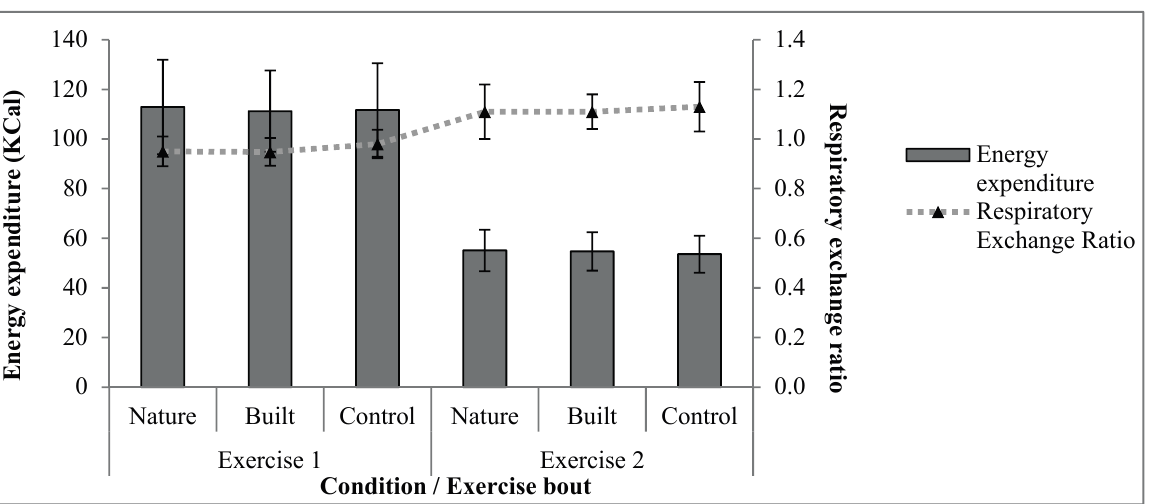
Figure 2. Mean (±SD) energy expenditure and respiratory exchange ratio by condition for Exercise 1 and Exercise 2; Exercise 1 duration was 15-mins, Exercise 2 values each represent 4:47-mins of